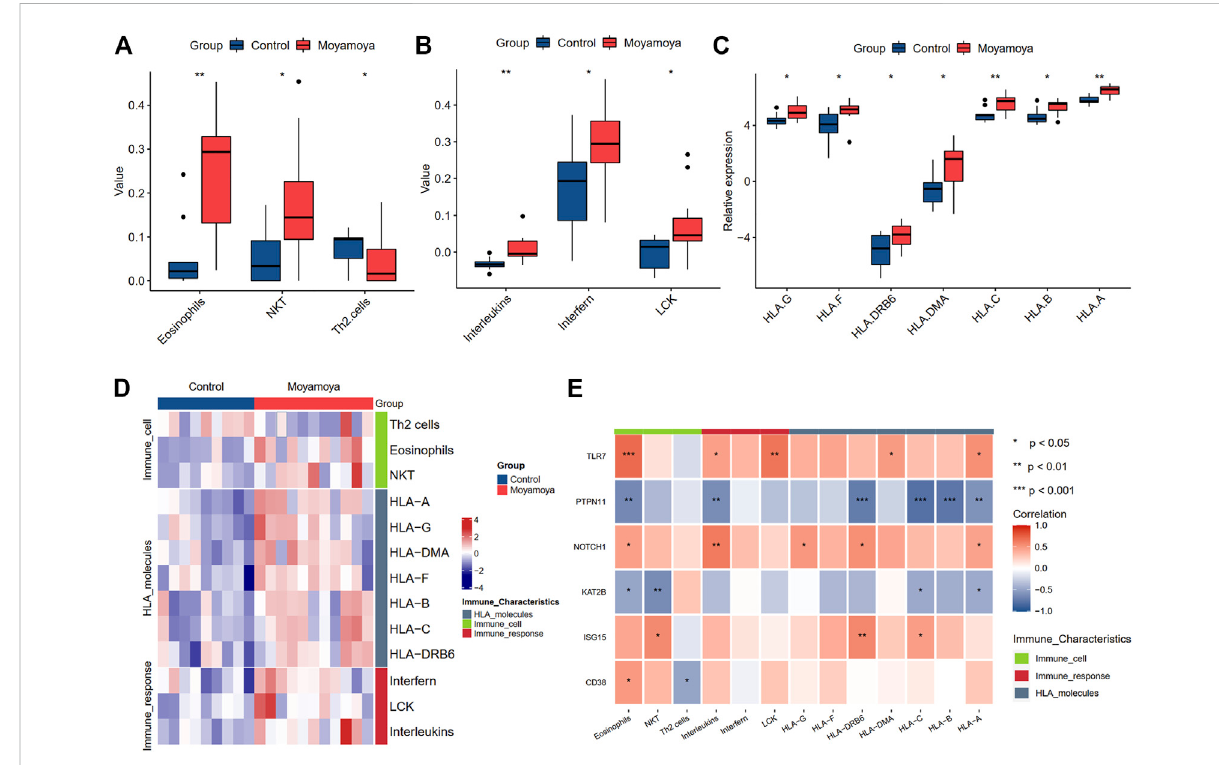
FIGURE 9 The signi fi cantly differential immune characteristics between MMD and controls. (A) The signi fi cantly differential immune cells. (B) The signi fi cantly differential immune activities. (C) The signi fi cantly differential expressed HLA molecules. (D) A heat map shows the landscapes of immune characteristics between MMD and controls. (E) The correlation of immune characteristics and six hub DEARGs. Signi fi cance level was denoted by * p -value < 0.05, ** p -value < 0.01, *** p -value < 0.001.